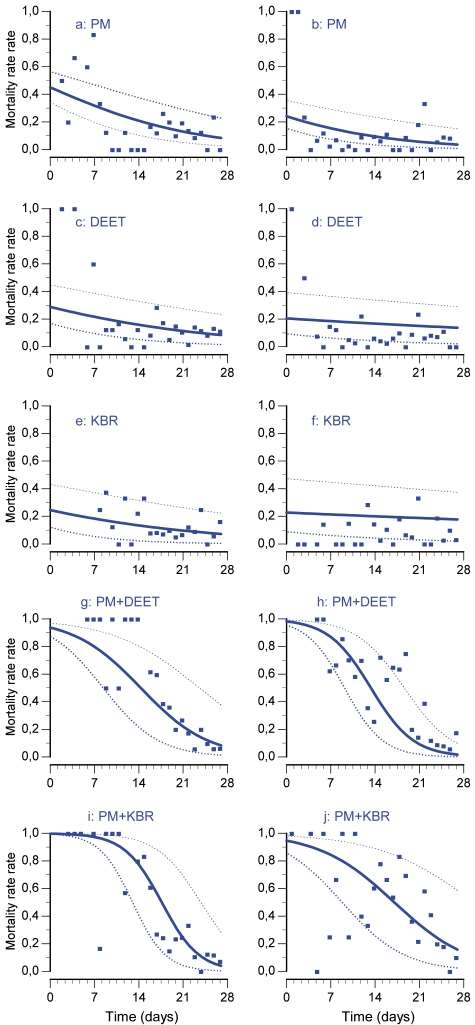
Mortality rates over time in the minimal adequate logistic regression model with standard error bounds.a, c, e, g and i illustrate the trial during dry season 2006; b, d, f, h and j illustrate the trial during rainy season 2006.